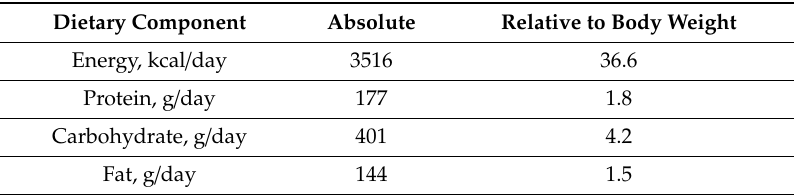
Table 1. Dietary intake at